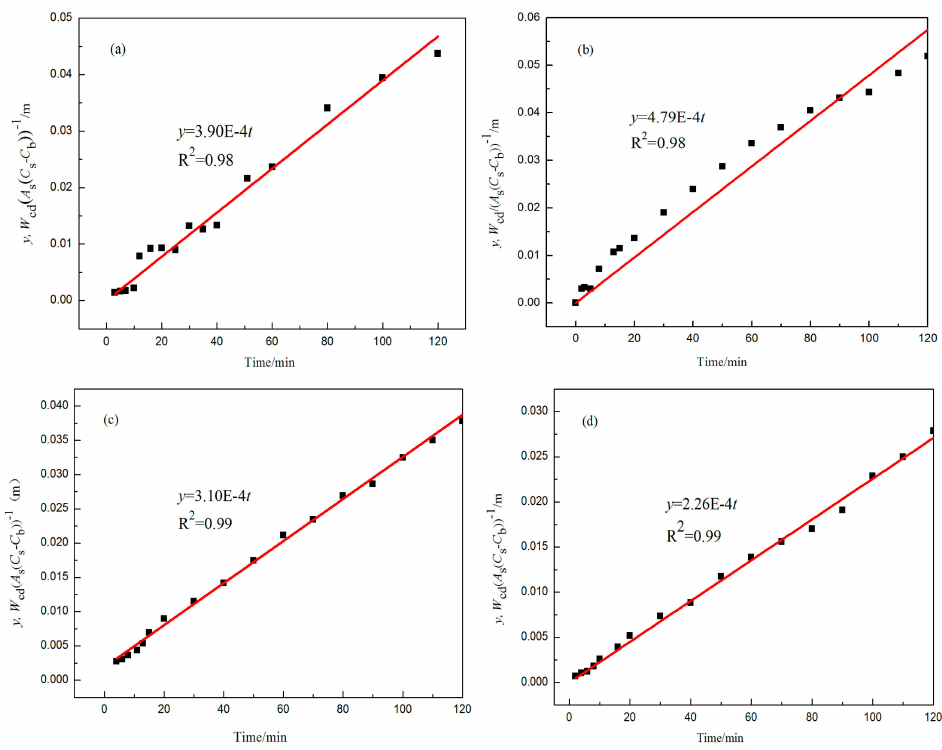
− 1 Figure 2. The relationship between W cd ( A s ( C s − C b )) and t of di ff erent cokes and ferrous materials. ( a ) Coke 1 ( R = 96.22%, m ci = 7.5 g), ( b ) coke 1 ( R = 99.95%, m ci = 0 g), ( c ) coke 2 ( R = 99.95%, m ci = 0 g), ( d ) coke 3 ( R = 99.95%, m ci = 0 g). Table 5. The typical values of k t in each experimental